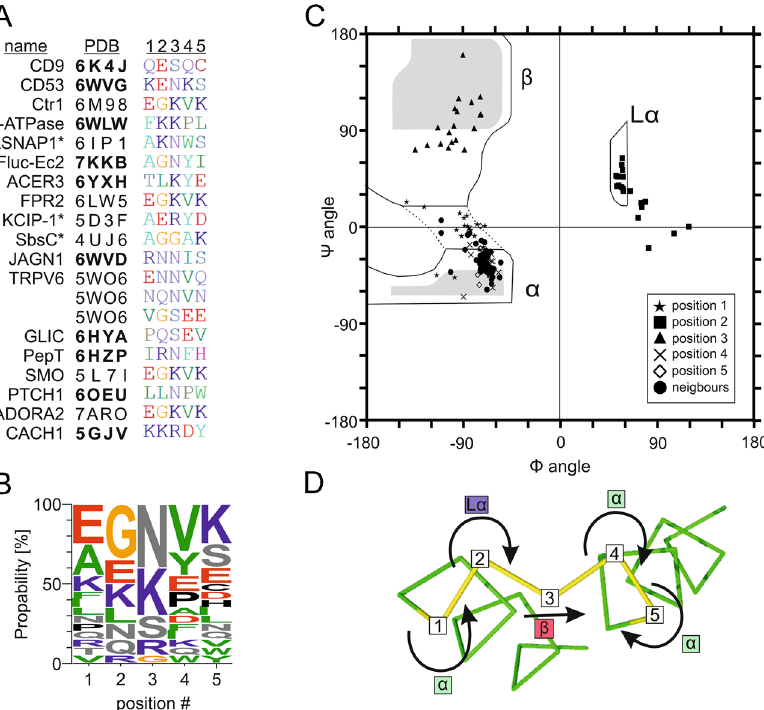
Figure 4. The M-motif is a common structural element formed independent of the SIL consensus sequence. ( A ) The two known tetraspanin structures with resolved M-motif and additional 16 examples of crystal structures containing in total 20 inter-helix turn M-motifs. Proteins are listed using short names, followed by the PDB entry number and the sequence of the M-motif. Mostly, the M-motif was found in membrane proteins but also in three cytosolic ones (marked with an asterisk). Examples in which the motif connects two TMSs were highlighted (PDB number in bold). For structural illustration of the M-motifs in the high-affinity copper transporter Ctrl1, V-ATPase and alpha-soluble NSF attachment protein see Fig. S5. ( B ) Amino acid frequencies in the M-motifs of the proteins listed in A. With the exception of the central asparagine, there is hardly overlap with the animal SIL core consensus sequence. ( C ) Analysis of the dihedral angles employing a Ramachandran plot reveals alpha-helical properties in positions 1, 4 and 5, left-handed helix in position 2, and beta-strand features in position 3. As expected, neighbouring residues are essentially alpha-helical. ( D ) The 180° turn of the direction of the protein backbone involves three structural elements. The turn is initiated by the left-handed character adopted by position 2. Between position 2 and 4 the gap is spanned by the beta-strand character of position 3. Finally, at position 4 already alpha-helicity in the opposite direction is realized. Please note that arrows shown at position 2 and 4 look identical but indicate different angle combinations, which is due to simplification in structure presentation. The alignment was created using BioEdit 28 v7.0.5 (http:// www. mbio. ncsu. edu/ BioEd it/ bioed it. html) and the illustration of residue frequency was done using Weblogo 33 3.7.4 (https:// weblo go. berke ley. edu/ logo. cgi). The presentation of the dihedral angles was done using GraphPad Prism version 6.04 for Windows (www. graph pad. com) and PyMOL 2.5 (https:// pymol.